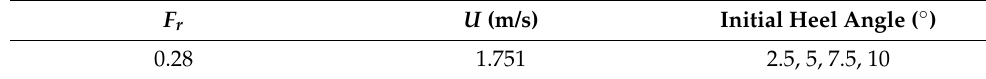
Table 4. Calculation cases of roll decay motion.